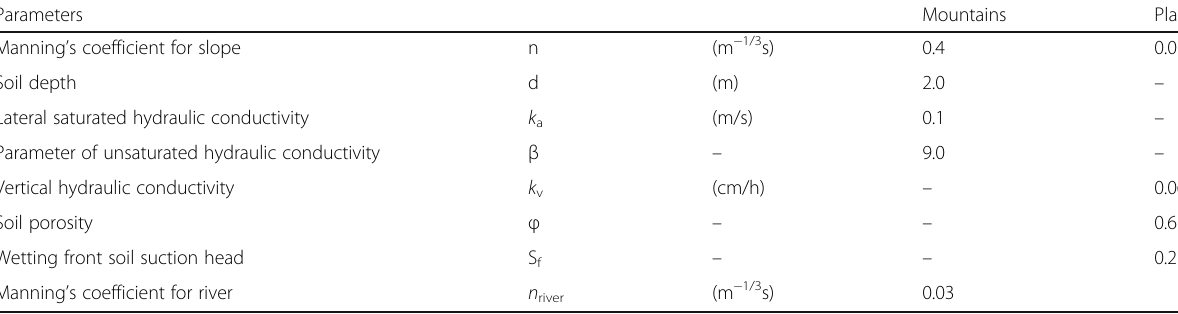
Table 1 The values of parameter setting of the RRI model used in the study Parameters Manning ’ s coefficient for slope Lateral saturated hydraulic